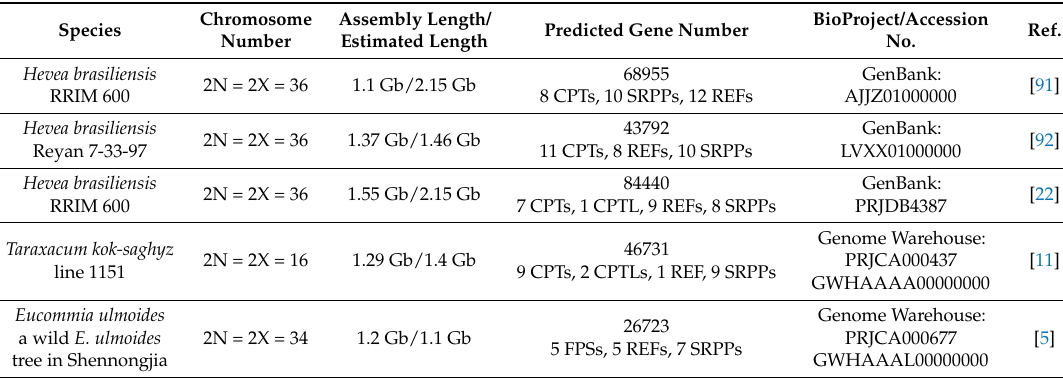
Table 1. Summary of genome assembly of the main rubber-producing